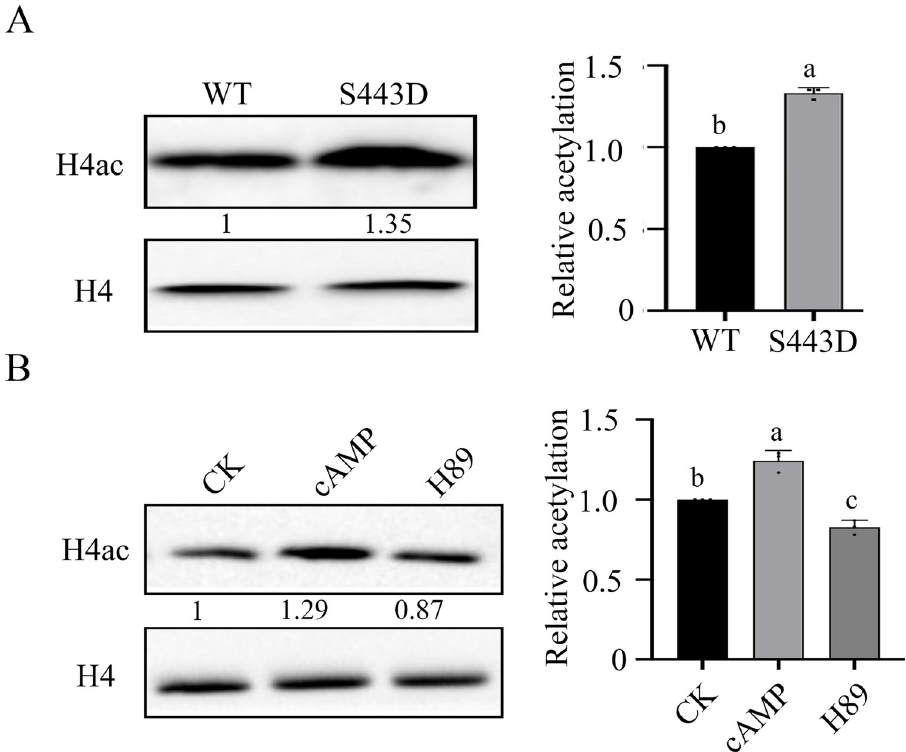
Fig 10. Phosphorylation of FgSnt1 S443 is important for H4 acetylation. (A). Western blots of total proteins isolated from PH-1 (WT) and its transformant expressing FgSNT1 S443D (S443D) were detected with anti-H4 and anti-H4ac antibodies (left) and quantified for the band intensities with Image J to estimate the relative H4 acetylation level after normalization with the non-acetylated H4 band. Data from three replicates were used to estimate the error bar. (B). Western blots of proteins isolated from regular PH-1 cultures (CK) and cultures treated with 50 μ M cAMP (cAMP) or 50 μ M H89 (H89) were detected with anti-H4 and anti-H4ac antibodies and quantified for the band intensities with Image J to estimate the relative H4 acetylation level after normalization with the non-acetylated H4 band. Data from three replicates were used to estimate the error bar.